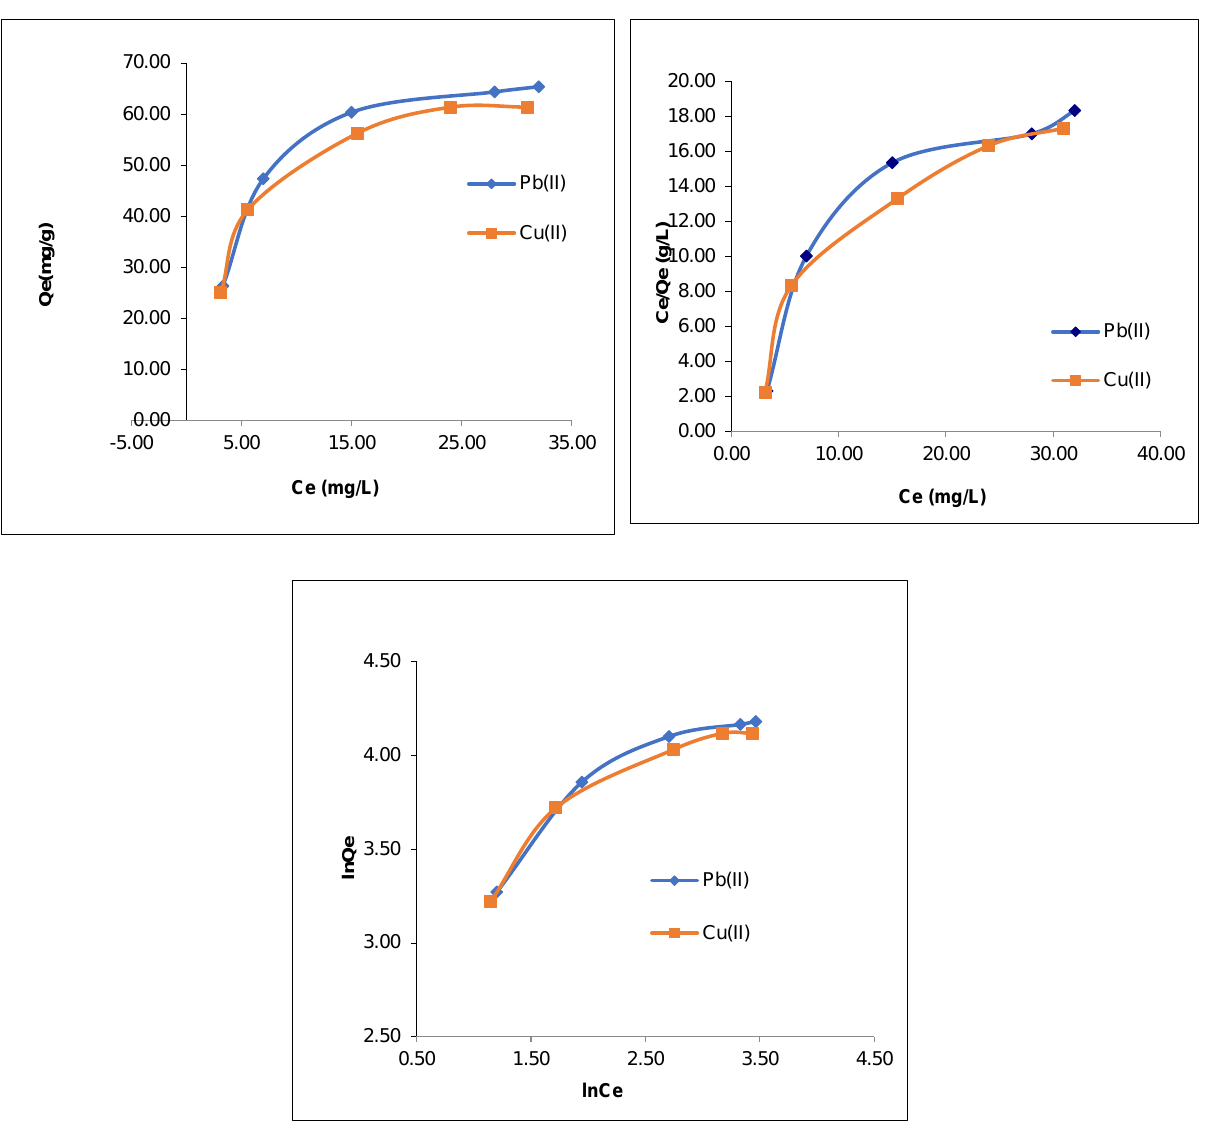
Figure 8. Langmuir and Freundlich adsorption plots of Pb(II) and Cu(II) ions on CMOISW. Mixing